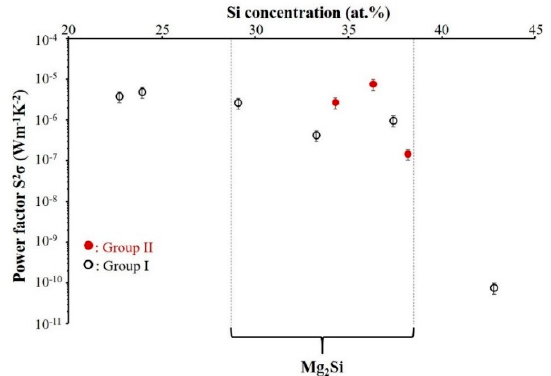
Figure 12. Power factor ( PF ) of Mg–Si thin films deposited on glass substrate vs. Si atomic concentration. (Selected zone indicates power factor of coatings with the composition closed to R P < 7 × 10 − 4 Pa and Group II: R P ≥ 7 × 10 − 4 Mg 2 Si). (Group I: R P < 7 × 10 − 4 Pa and Group II: R P ≥ 7 × 10 − 4 Pa).